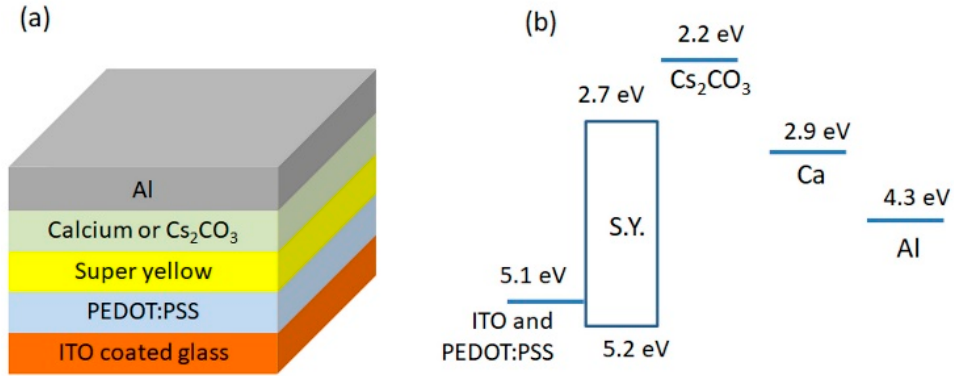
Figure 7. Schematic representation of ( a ) PLED structure and ( b ) energy levels of functional layers [59] .